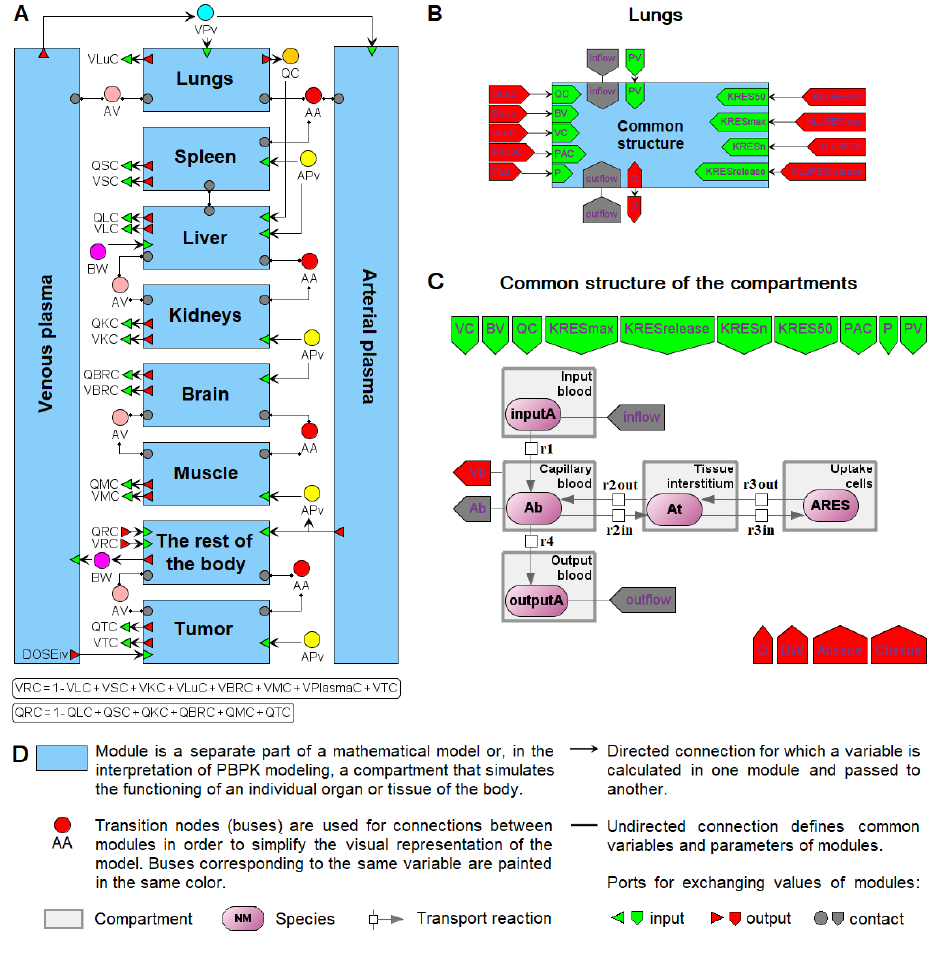
Figure 6. An example of a PBPK model of nanoparticle delivery to solid tumors in mice constructed by Cheng et al. [50] and implemented in BioUML (adapted from [89]). ( A ) Modular representation of the computational model that includes 10 compartments: arterial and venous plasma, lungs, spleen, liver, kidneys, brain, muscle, tumor, and remaining tissues. ( B ) Representation of the lung compartment as a module with common equations of nanoparticle biodistribution in organs that receives specific input values of kinetic parameters. ( C ) Definition of the module of the common compartmental structure, including membrane-limited transcapillary transport, endocytic uptake, and exocytic release of NPs. ( D ) Graphical notation used in BioUML to represent the model in SBML format and SBGN